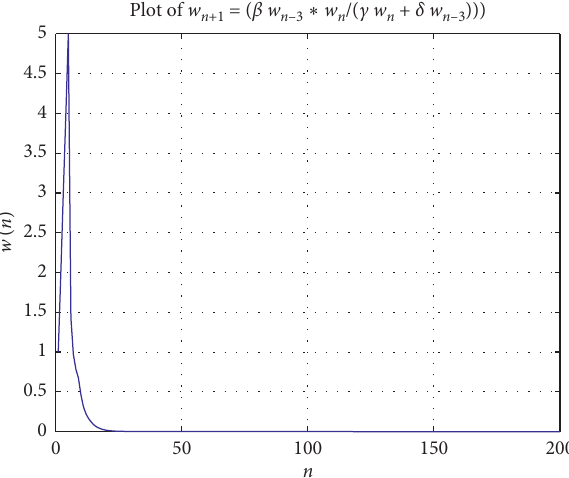
Figure 3: Global asymptotic stability of equation (64).